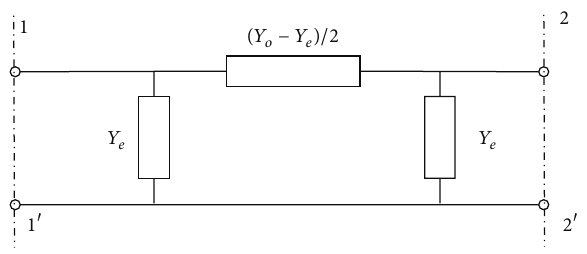
Figure 5: Equivalent two-port network for strip asymmetric folded dipole.